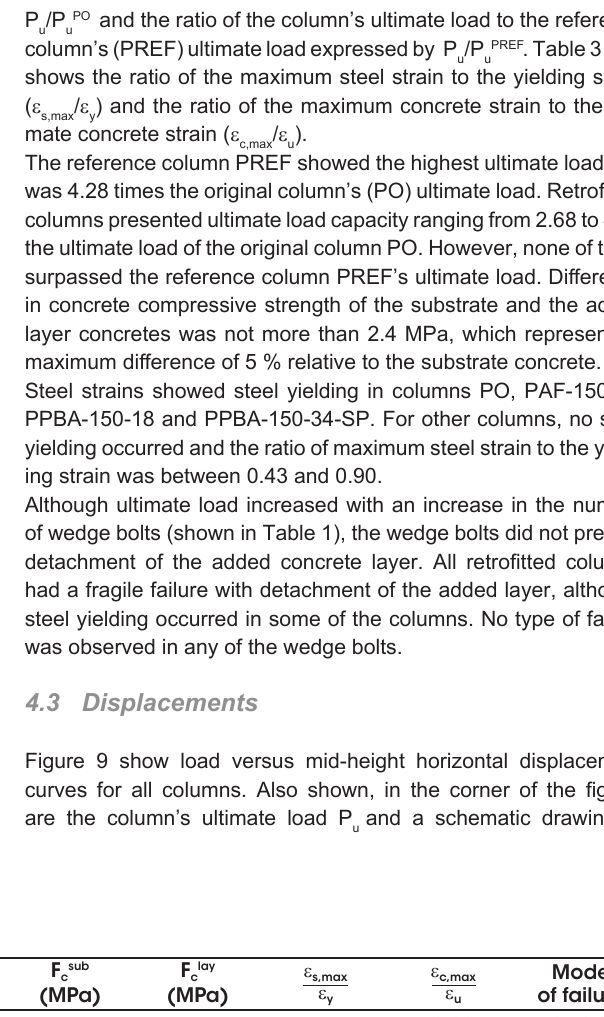
Figure 9 show load versus mid-height horizontal displacement